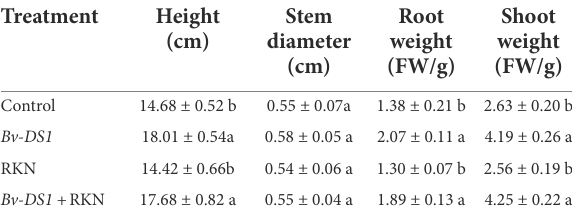
Data are presented as mean ± SE of three independent biological replicates of a total of 18 tomato plants for each treatment. Different letters indicate significant differences ( p < 0.05) according to one-way ANOVA with Tukey’s multiple range